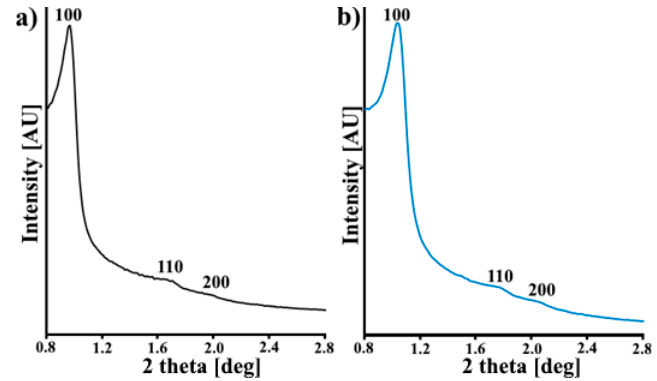
Figure 2. XRD diffractograms of ( a ) CMK ‐ 3 and ( b ) N ‐ CMK ‐ 3.